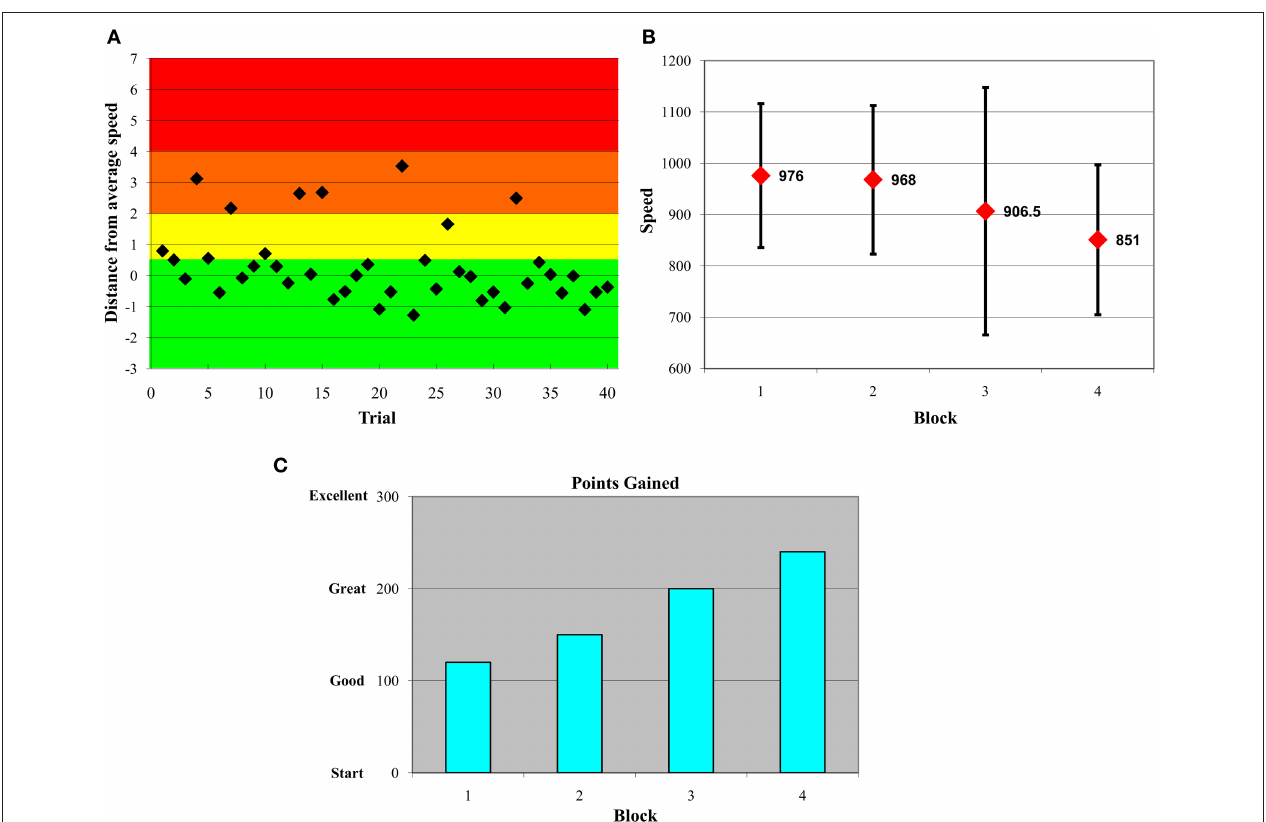
orange zone, and − 50 if in the red zone. The y -axis represents numbers of standard deviations from a participant’s own median from the previous block. (B) Feedback plot of response time medians and SDs across blocks. (C) Feedback plot of points gained across blocks.